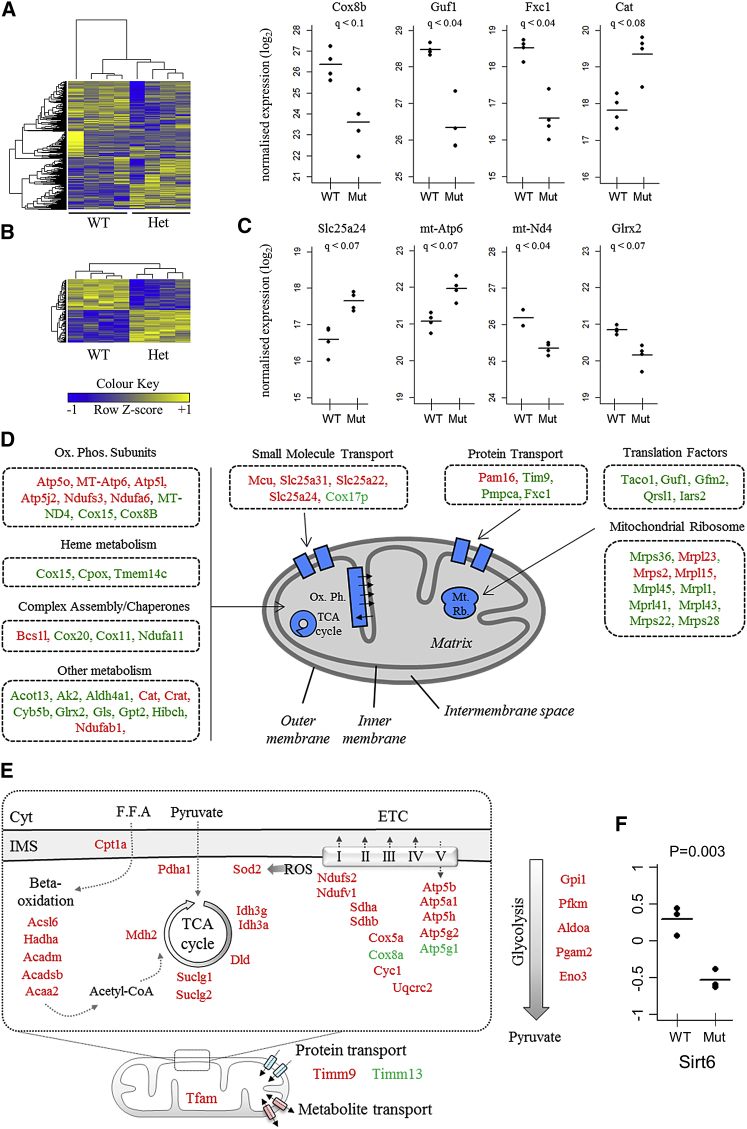
Functional Genomics Profiling of Eif6+/− Muscle Reveals Substantial Mitochondrial Reprogramming(A and B) Representation of the proteomics data using a heatmap. Row data are standardized for visualization purposes. Shown are all proteins for which a measurement was obtained for all 8 samples (918 proteins) (A). Shown are the differentially expressed proteins with a FDR < 10% (120 proteins) (B).(C) Vertical dot plots representing a selection of the differentially expressed mitochondrial factors revealed by the proteomics analysis (FDR < 10%).(D) Diagrammatic representation of proteomics data showing differentially expressed mitochondrial proteins (green, downregulated; red, upregulated; FDR < 10%).(E) Diagrammatic representation of polysomal mRNA analysis of Eif6+/− and WT skeletal muscle showing altered mRNA loading of mitochondria-related genes; green, downregulated; red, upregulated; absolute log2-fold change > 2, p < 0.05.(F) Ratio of polysomal versus total Sirt6 mRNA in WT and Eif6+/− muscle, p = 0.003.